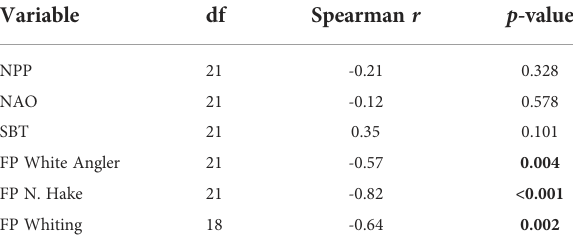
Statistically signi fi cant values are